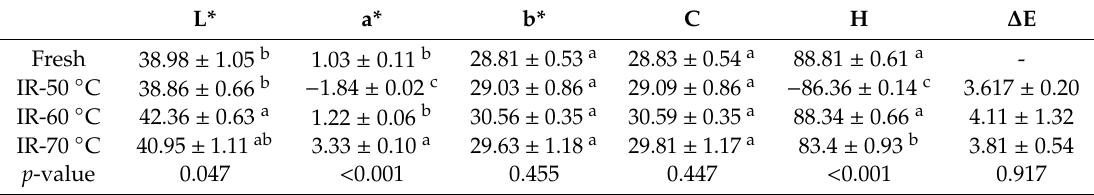
Table 2. Color indicators of linden leaves at di ff erent